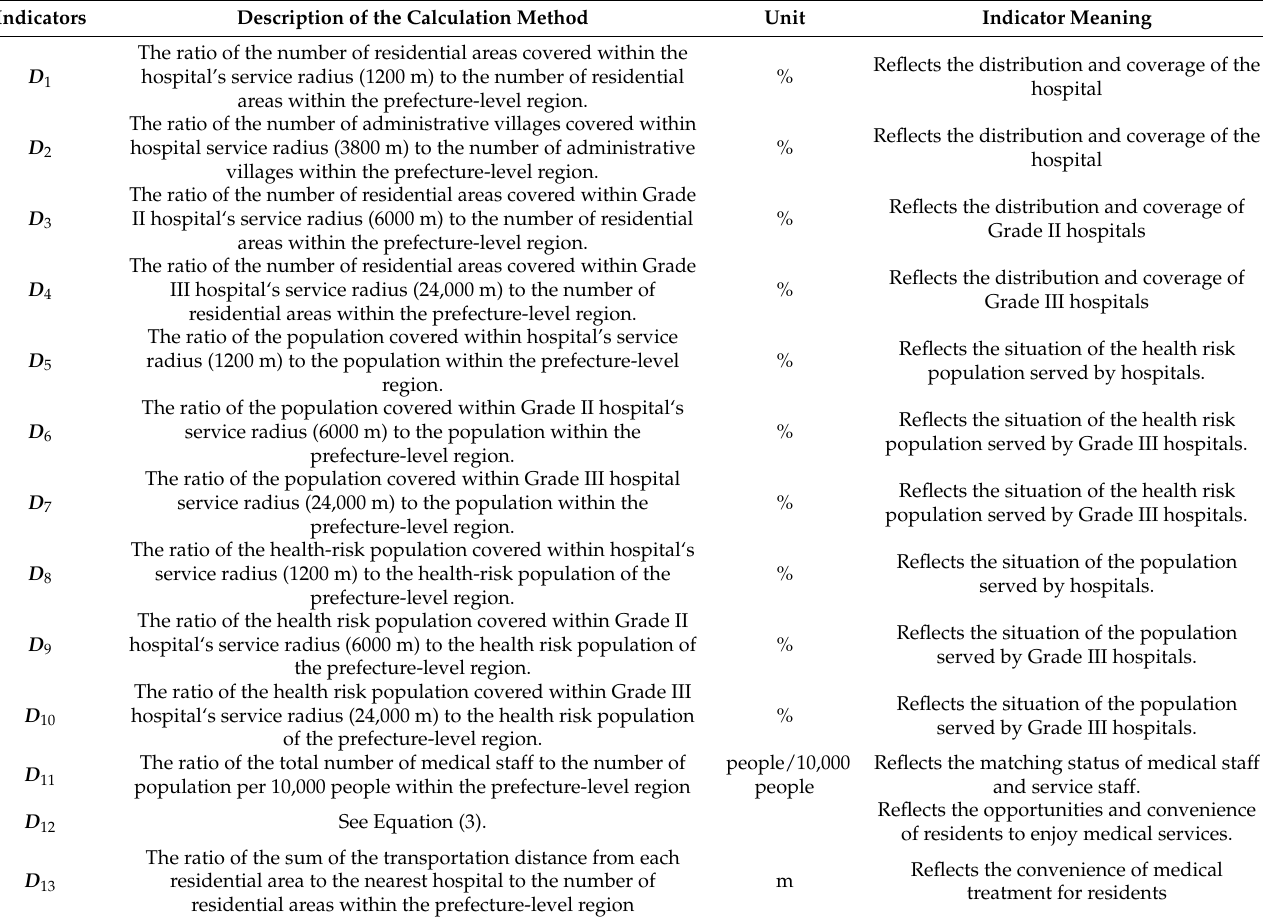
Table 4. Equalization evaluation indicators and calculation method of basic medical